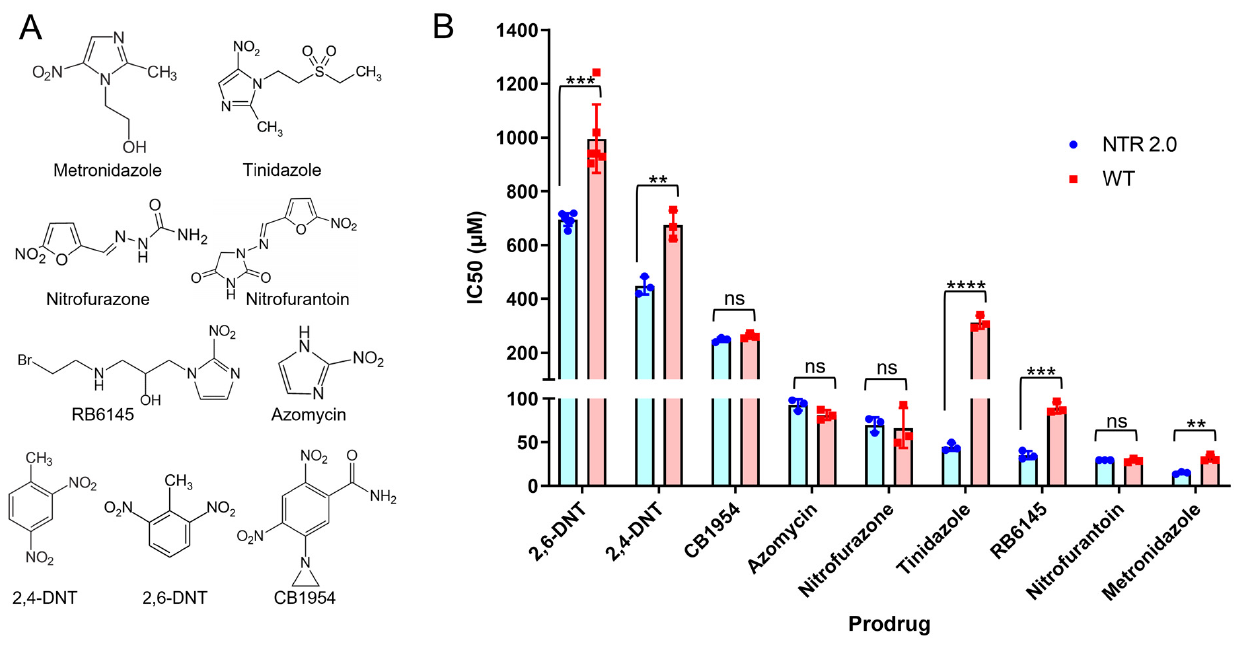
Figure 7. Activity of NTR 2.0 with a panel of nitroaromatic prodrugs. ( A ) Structures of the nitroaromatic prodrugs tested in this work. ( B ) IC 50 values for E. coli cells expressing NTR 2.0 or the parental V. vulnificus NfsB enzyme (wild-type; WT) following challenge with each prodrug. Notation above bars denotes statistical significance between strains: ** = p ≤ 0.01, *** = p ≤ 0.001 and **** = p ≤